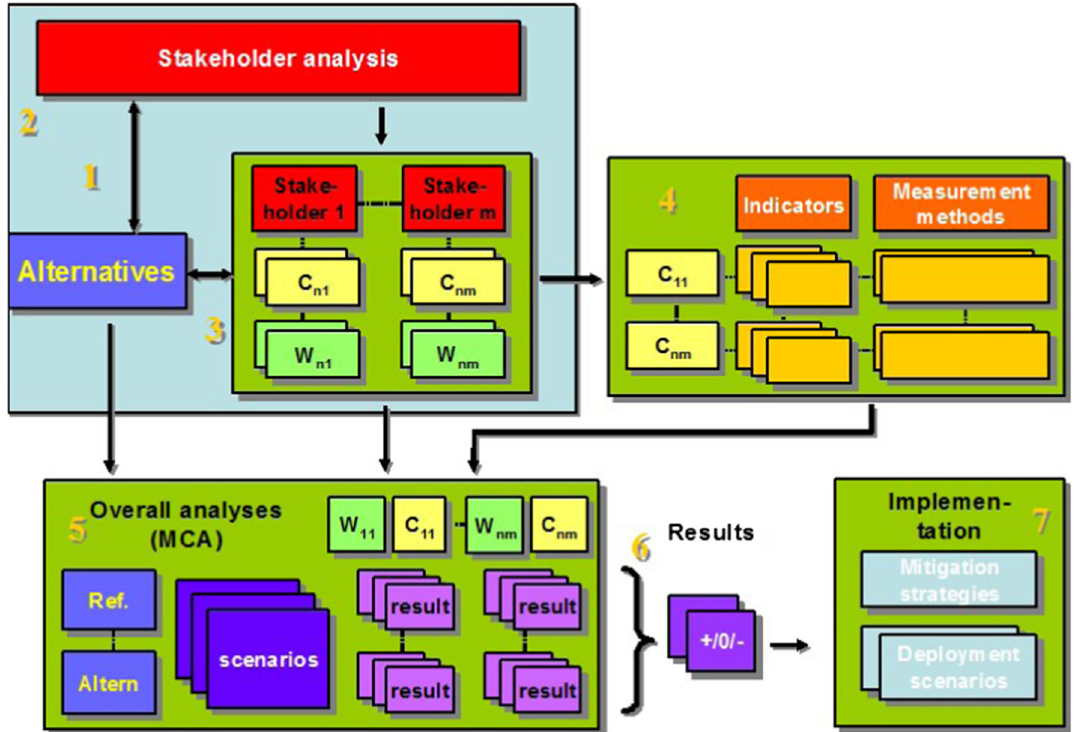
Fig.1 Methodological steps for the application of Multi – Actor Multi – CriteriaAnalysis (MAMCA) [17]. C n1 … .C nm : Evaluation Criteria. W n1 … W nm : Weights assigned to the Evaluation